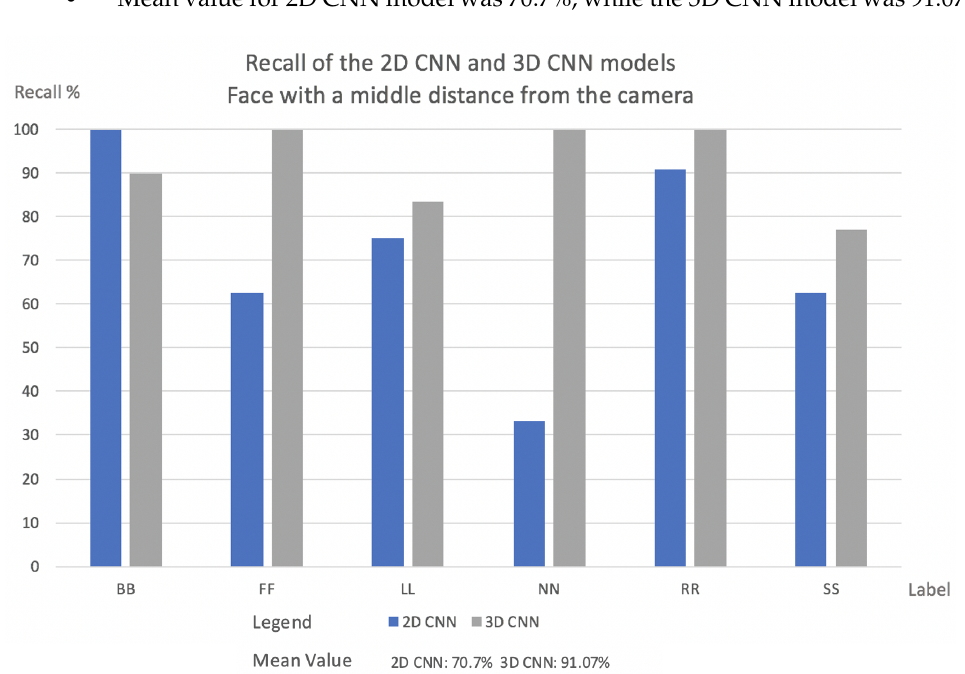
Figure 7. The percentage of labels successfully classified by the network in both models for videos facing the camera at a middle